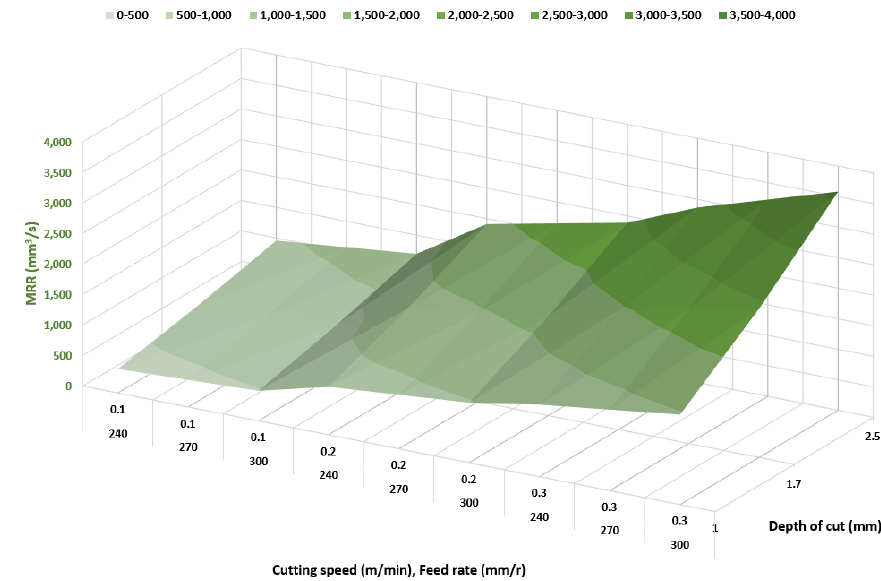
Figure 11. Material volume removal rate (MRR) in relation to the selected range of a p , f , v c .